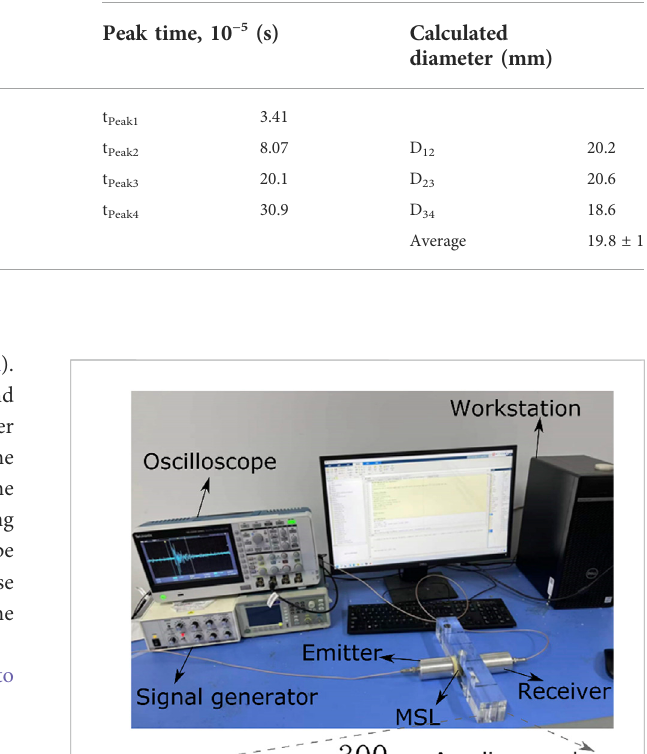
TABLE 2 Peak time values and calculated diameters from simulation. With MML Without MML Peak time, 10 − 5 Peak time, 10 − 5 (s) Calculated diameter (mm)